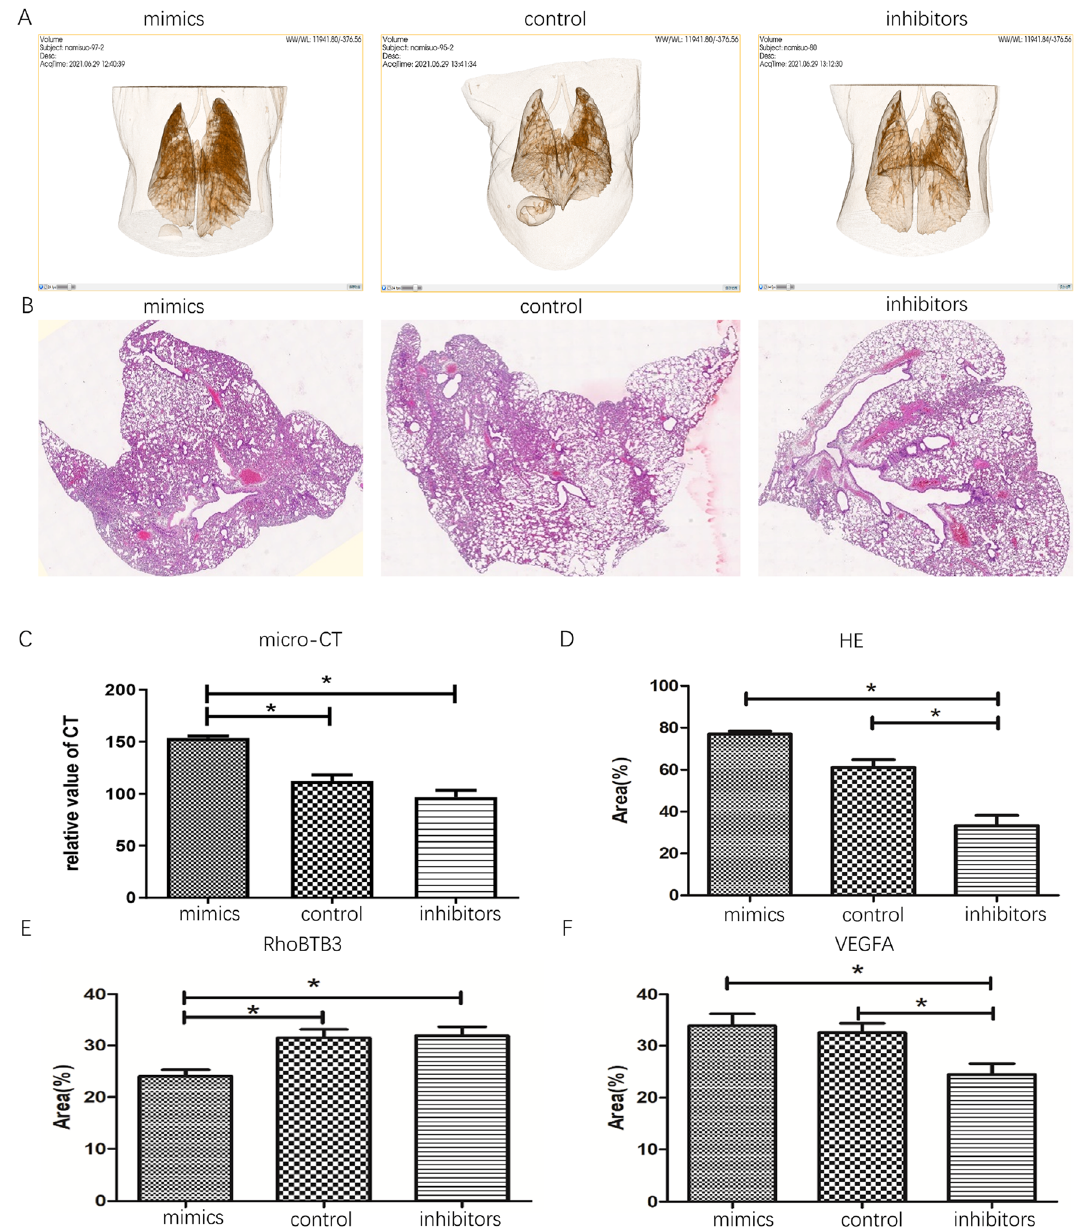
Figure 3. miR-142-3p regulates RCC metastasis in vivo. 786-O cells were transfected with miR-control, miR- 142-3p-mimics, and miR-142-3p-inhibitors and implanted into the nude mice. The lung metastasis imaging by micro-CT ( A ) and the relative CT value was analyzed using Image J software ( C , P < 0.05). The HE stained sections were photographed under the microscope ( B ), and the expression area was also assessed statistically ( D , P < 0.05). The IHC staining was used to validate the expression of RhoBTB3 and VEGFA in the tissues ( E , F